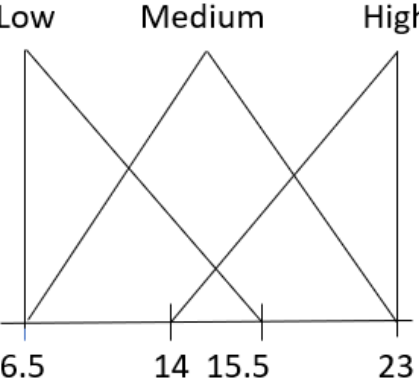
Figure 4. Representation of the linguistic variable Price in the Wine